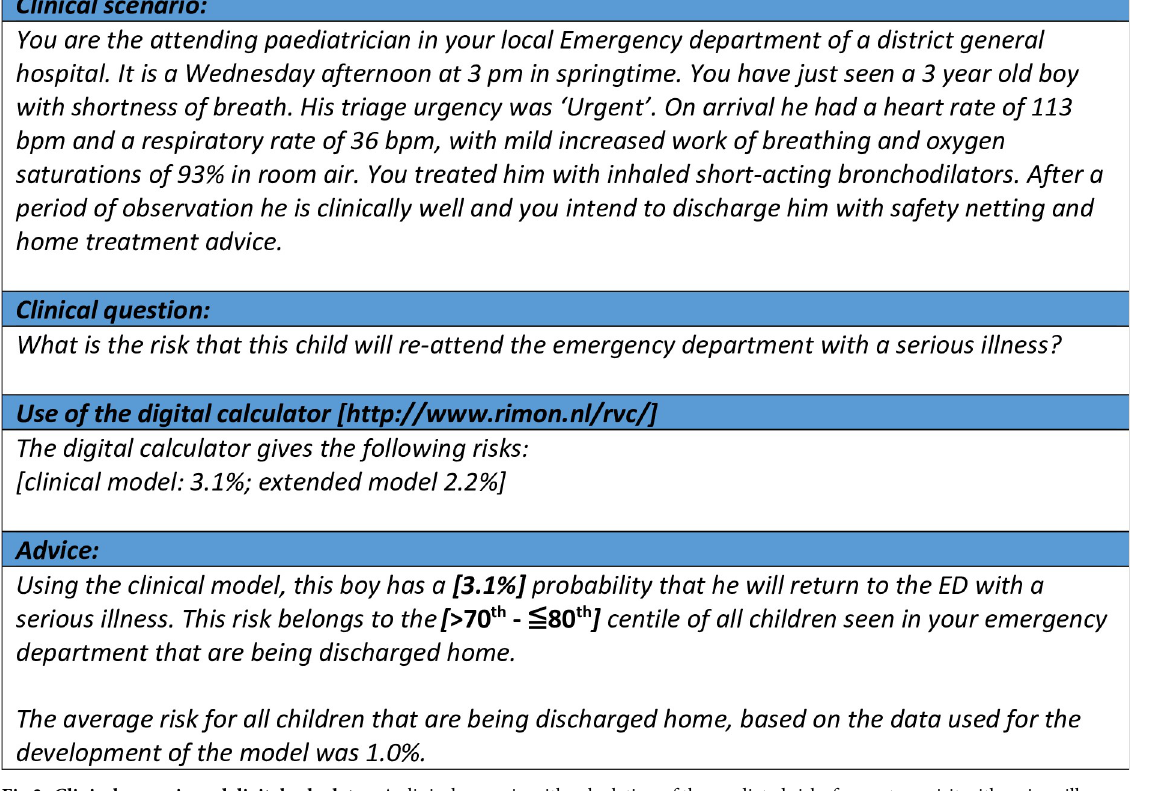
Fig 3. Clinical scenario and digital calculator. A clinical scenario with calculation of the predicted risks for a return visit with serious illness after discharge from the emergency department, using the digital calculator at http : //www . rimon . nl/rvc/ .